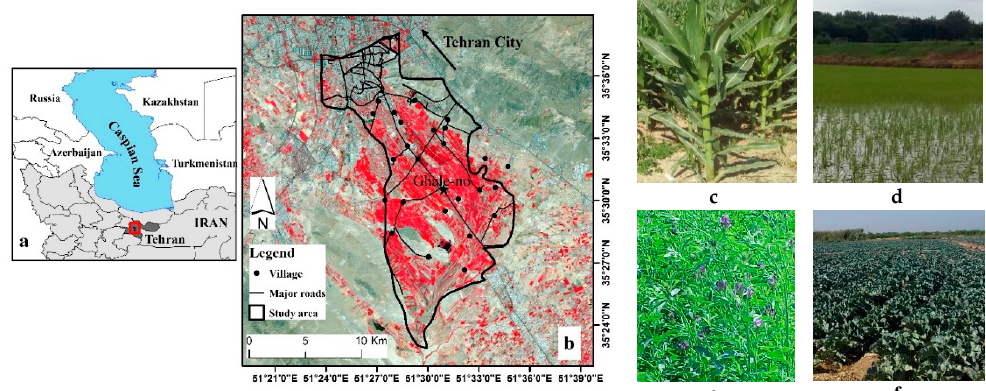
Figure 1. ( a ) Study area in the Tehran province. ( b ) Location of the study area in proportion to the surroundings of Tehran; Ghale-Nou county. Image in the background (band 8 (near infra-red (NIR)), band 4 (red), band 3 (green) as RGB (Red Green Blue) composition) are from Sentinel-2A at 21 August 2017, in almost near the flowering stage of certain crops (e.g., silage maize) of the region. ( c ) Silage maize. ( d ) Rice. ( e ) Alfalfa. ( f ) Vegetables field photos.